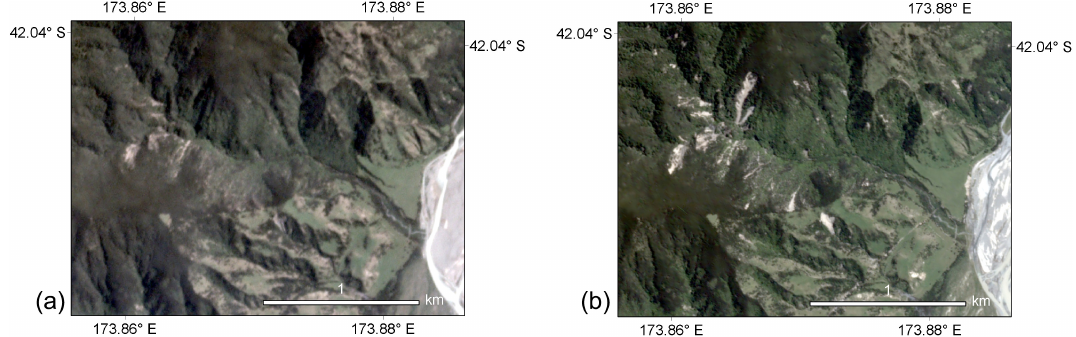
Figure 8. PlanetScope images on (a) 27 October, (b) 21 November 2016 showing landslides caused by the 14 November 2016 Kaikoura earthquake. To the lower right, the surface rupture is also clearly visible. Location: rectangle F in Fig.